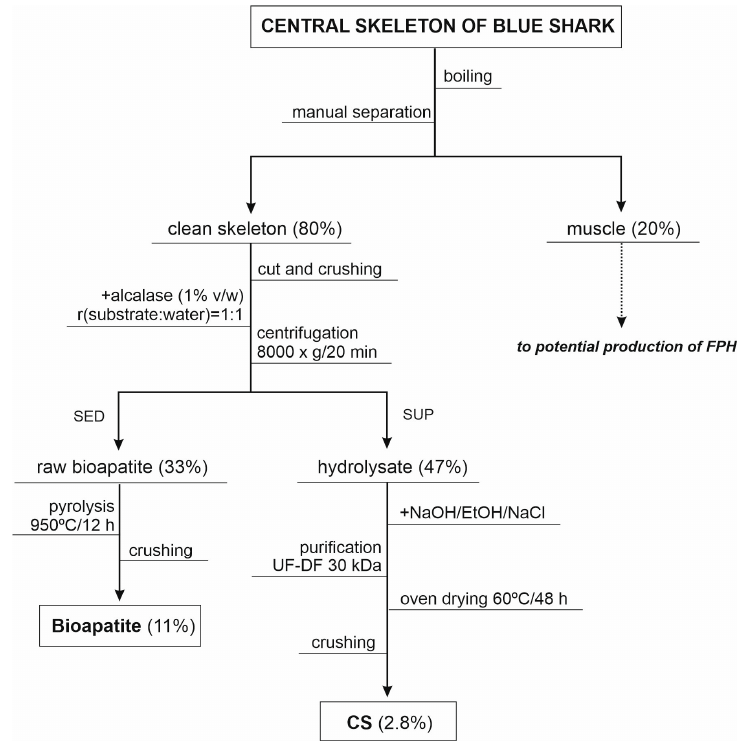
Figure 1. Flowchart of steps studied for the isolation of chondroitin sulfate (CS) and bioapatite from skeleton wastes of blue shark. Percentages of products recovery ( w / w of initial skeleton) are shown in brackets. FPH: fish protein hydrolysates, SED: sediment and SUP: supernatant.